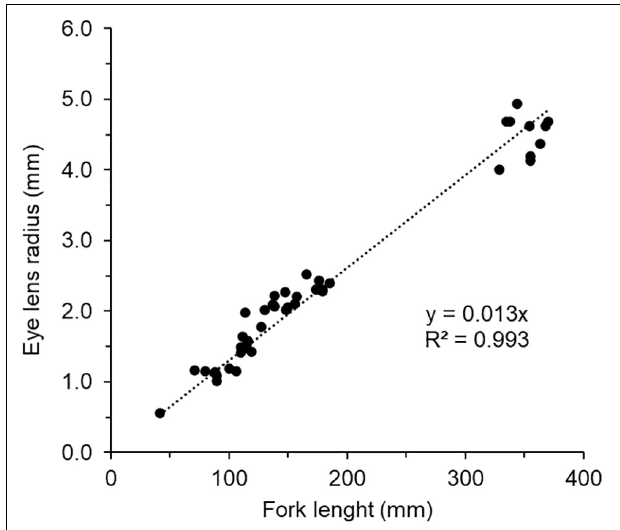
FIGURE 3 | Linear regression of fork length and lens radius of chub mackerel ( n = 46). The sample details are shown in Supplementary Table 1